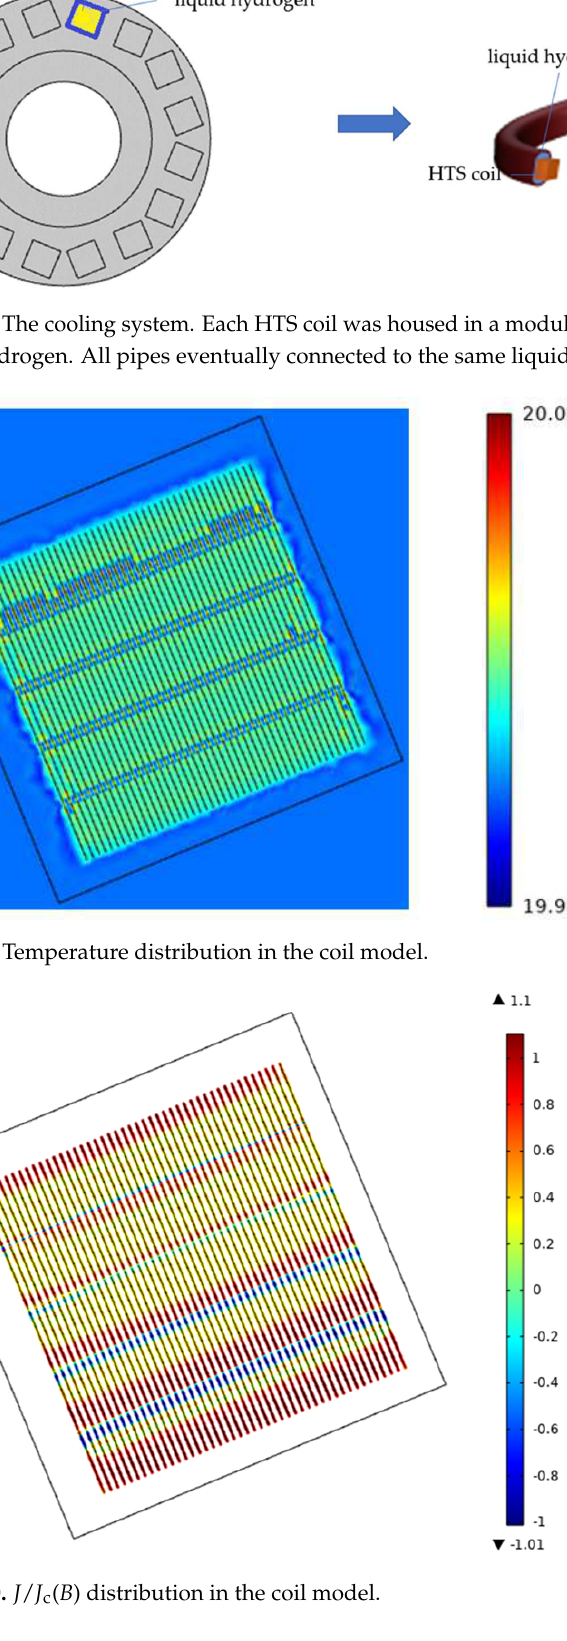
Figure 11. Instantaneous AC loss in the coil model. 3.3. Results Under the condition of 10 ohms of pure resistive load per phase, the generator’s sin- gle-phase peak voltage was 2620 V, and the total output power was 1.03 MW, which met the expected requirement. The total weight of the superconducting generator is the sum of the weights of all components. When calculating the volume, we used numerical calculation as a supple- ment to the simulation to avoid the error caused by the lack of curved parts in the 2D model. Table 3 lists the materials and weights of each component, where the weight of the superconducting windings is estimated according to the density of Hastelloy. Based on the results of simulation and numerical calculation, the generator’s total weight was 111.10 kg, indicating that the design met the expected power density. Table 3. Weight of the generator components. Component